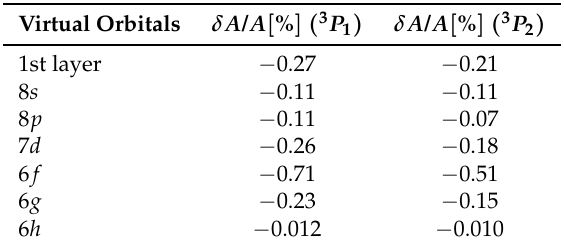
Table 5. Relative changes in the hyperfine constant A from the preceding calculation as the virtual orbitals were included in the order 1st virtual layer, 8 s , 8 p , . . ., 6 h . for cc substiutions from 4 spdf 5 spd . Virtual Orbitals δ A / A [ % ] ( 3 P 1 ) δ A / A [ % ] ( 3 P 2 ) 1st